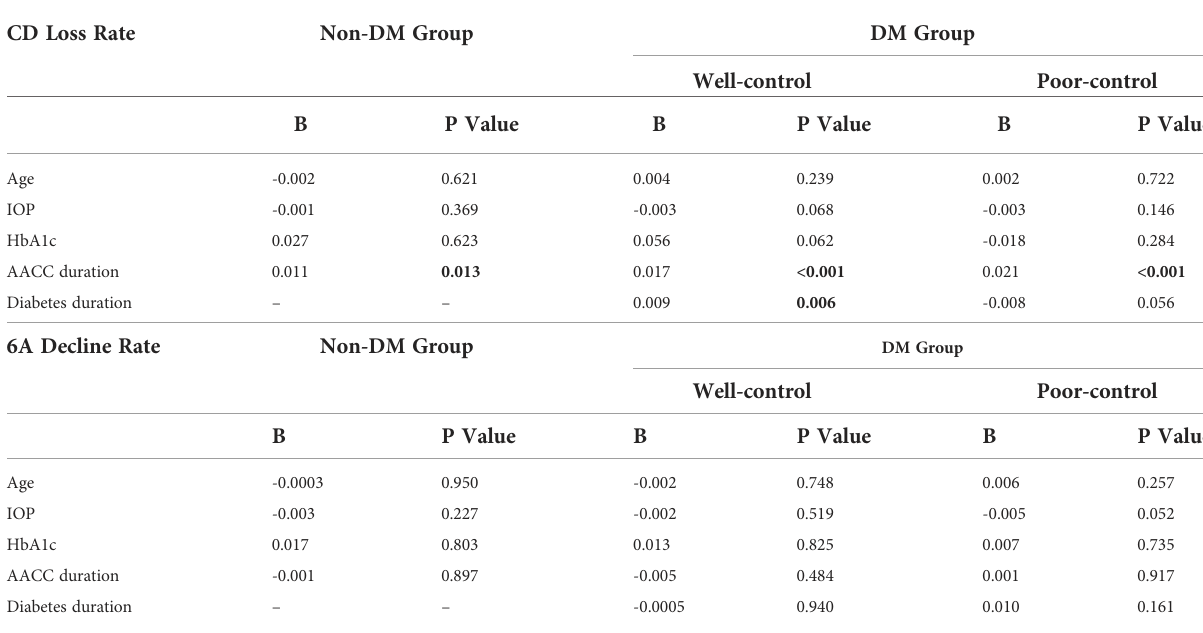
TABLE 3 Multivariate regression analysis of the age, intraocular pressure (IOP), HbA1c, AACC duration, diabetes duration and endothelial cell density (CD) loss rate andpercentage of hexagonal cells (6A) decline